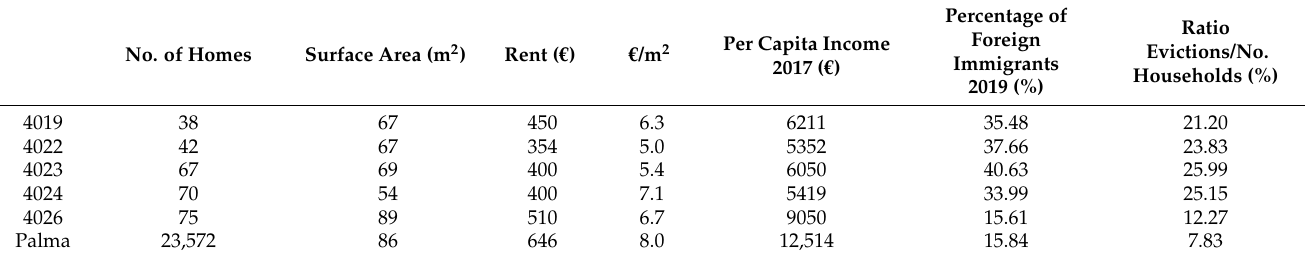
Table 3. Rented housing (2018) and its link with other economic and social variables by census